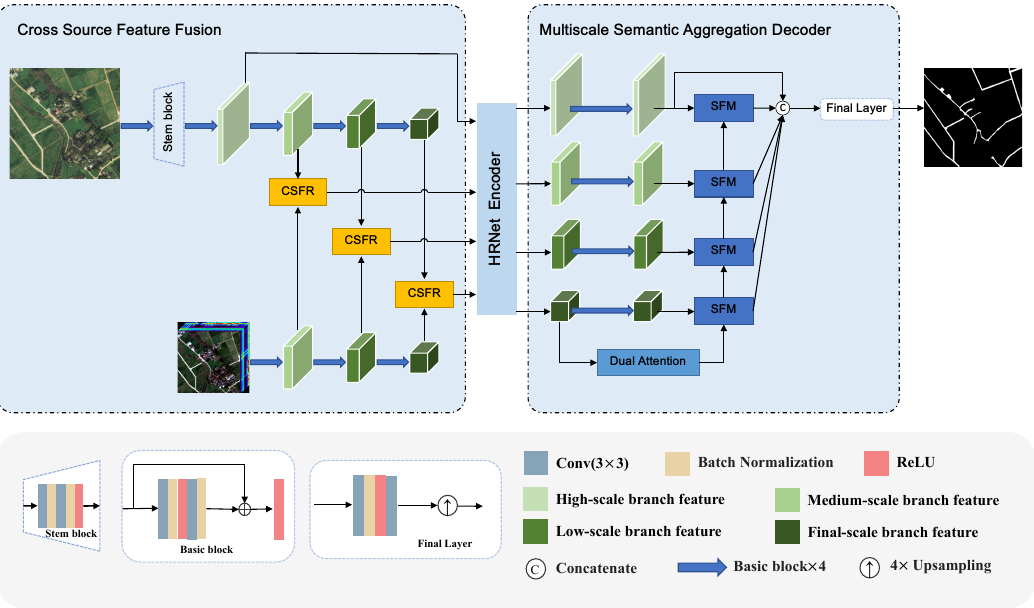
Figure 3. The overall structure of